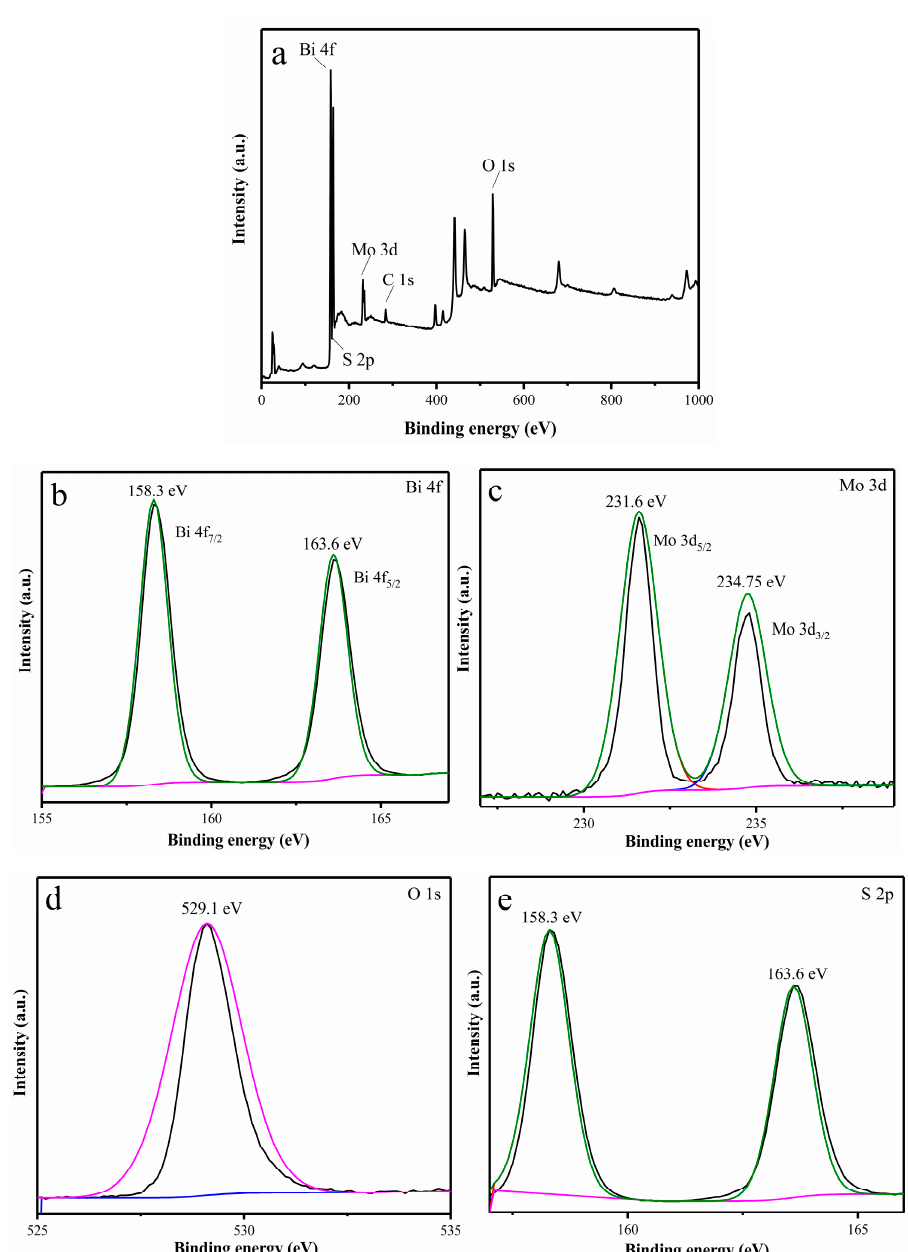
Figure 9. X-ray photoelectron spectra (XPS) of 1% S-doped Bi 2 MoO 6 sample: ( a ) full spectrum, ( b ) Bi 4f, ( c ) Mo 3d, ( d ) O 1s, and ( e ) S 2p.